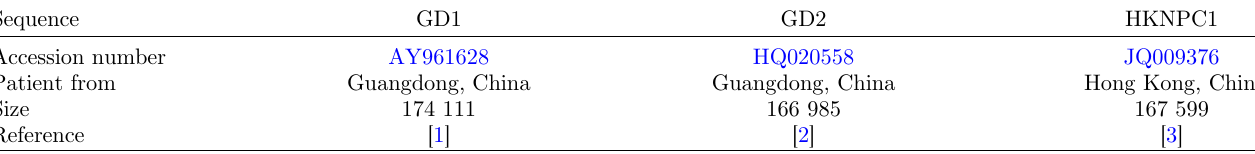
Table 2. EBV genomes isolated from NPC